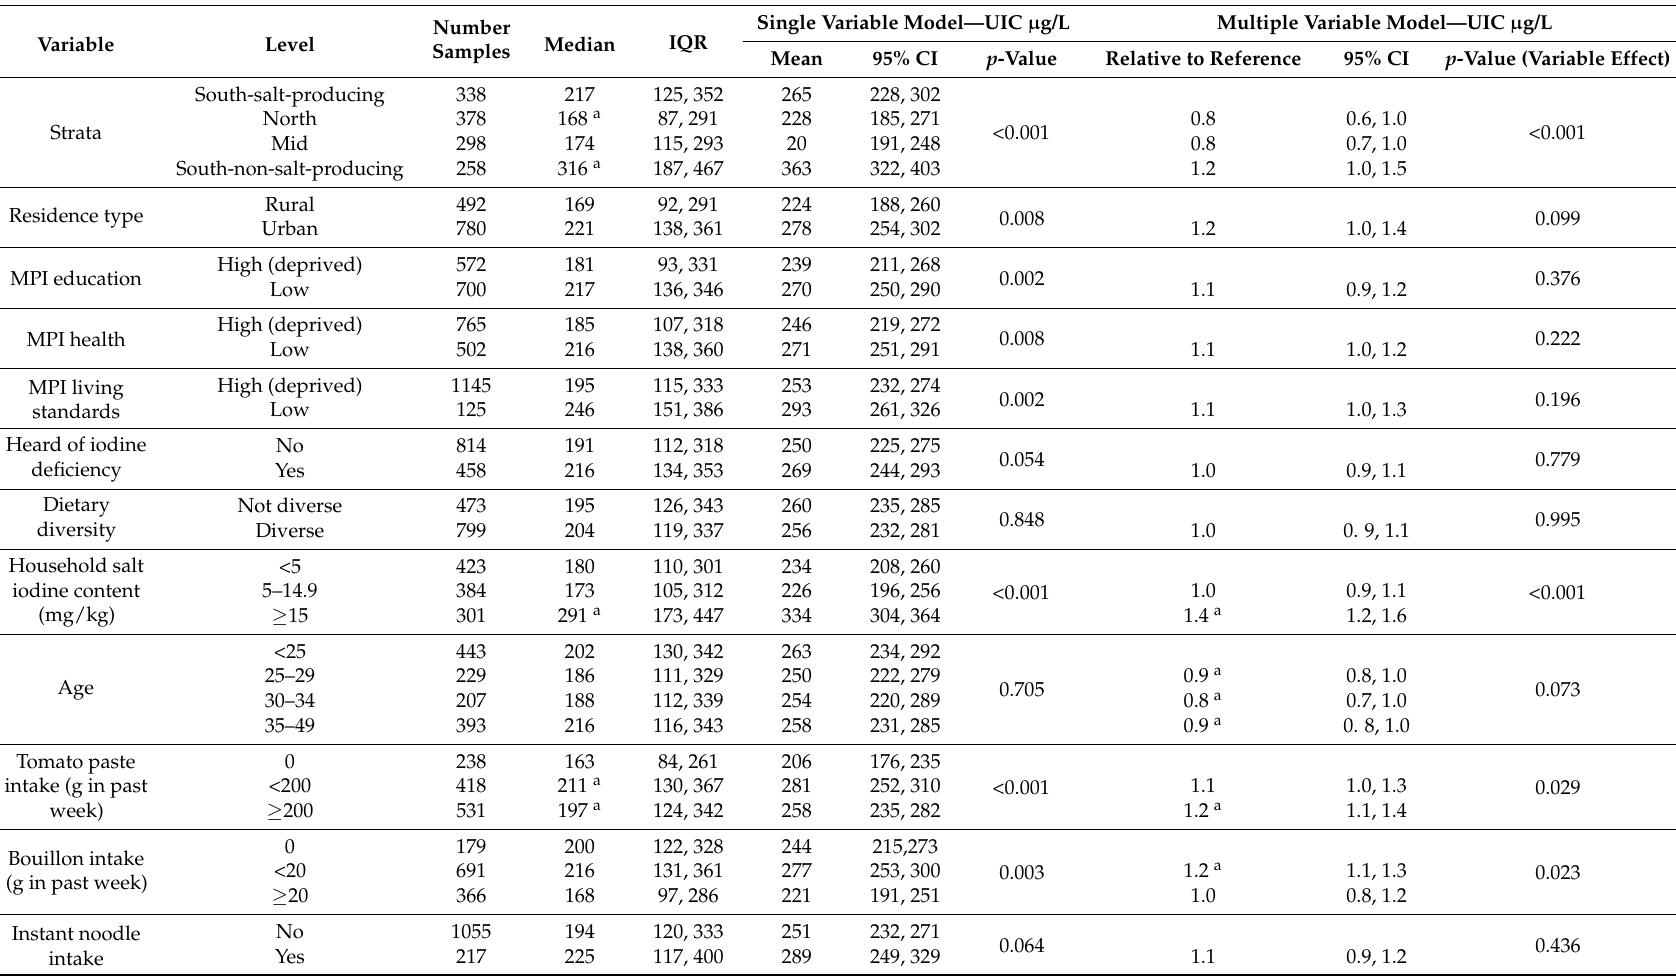
Table 3. Regression analyses of factors associated with urinary iodine concentration (UIC) µ